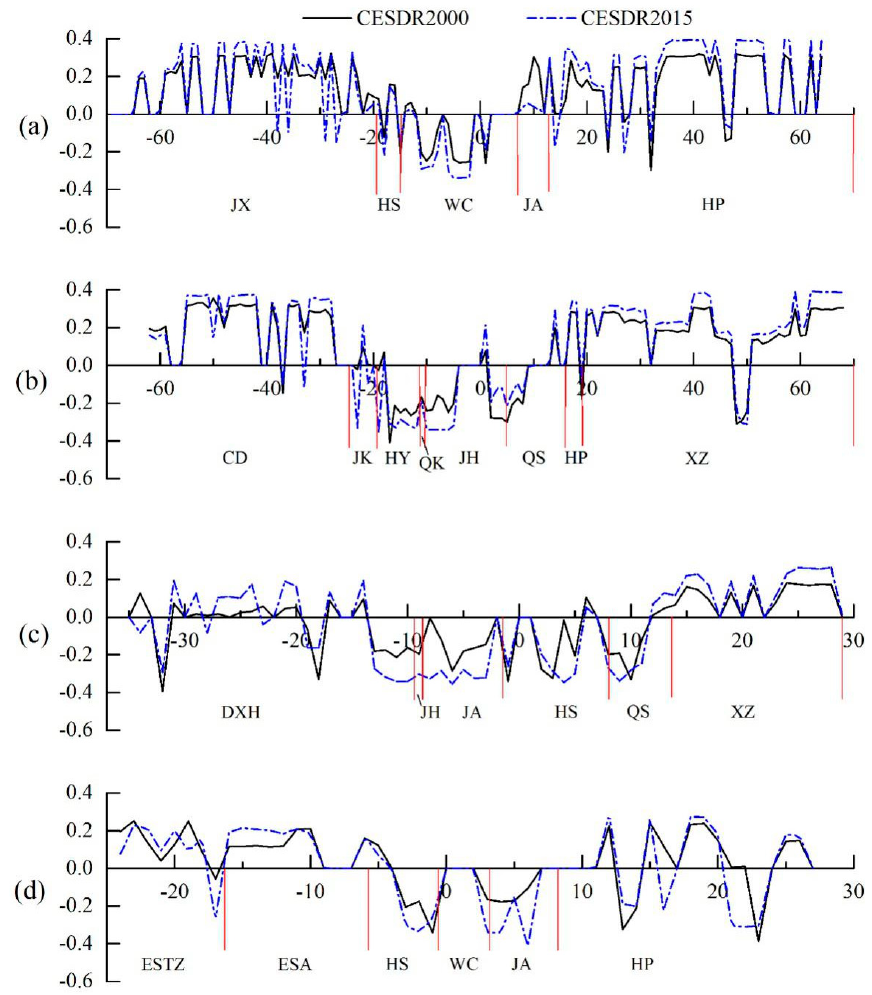
Figure 7. Results of gradient analysis of CESDR along four transects: ( a ) north–south, ( b ) east–west, ( c ) northeast–southwest, and ( d ) northwest–southeast in Wuhan City.